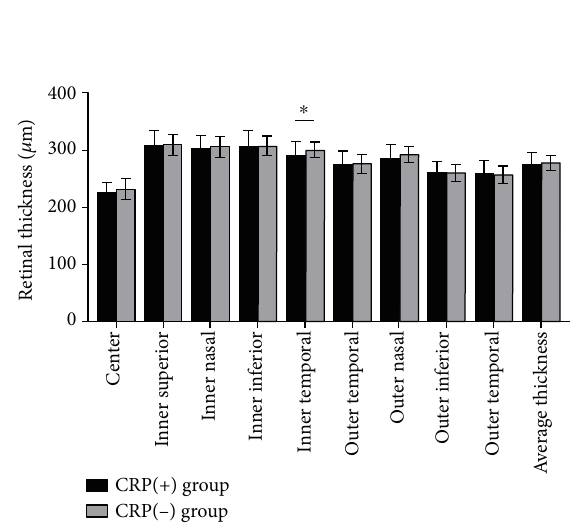
Figure 1: The retinal thickness of nine sectors of the ETDRS grid. The retinal thickness in the CRP ( − ) group was signi fi cantly thinner than that in the CRP ( − ) group only in the inner temporal sector of the ETDRS grid. ∗ p < 0 : 05